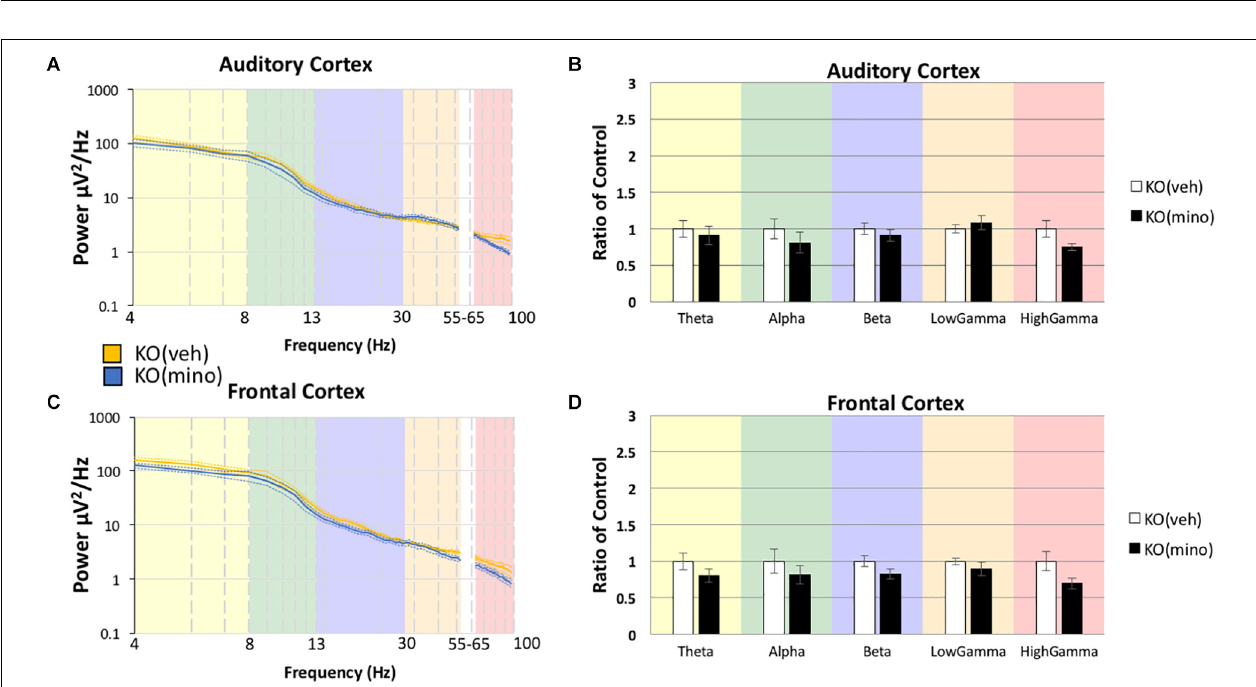
FIGURE 4 | Minocycline effects on gamma power were no different from vehicle effects in the Fmr1 KO mice. The 10-day minocycline effectiveness was compared against a 10-day vehicle treated group in Fmr1 KO mice. Mean power density was calculated for both drug conditions using both auditory and frontal cortex electrodes (A,C) . No statistical significance was observed on this measure for KO mice (B,D) . Minocycline is not better or worse than a vehicle control on resting EEG power spectral density (12 minocycline KO and 11 vehicle KO; * p < 0.05, ** p < 0.01, *** p < 0.001, **** p < 0.0001, # p < 0.00001).